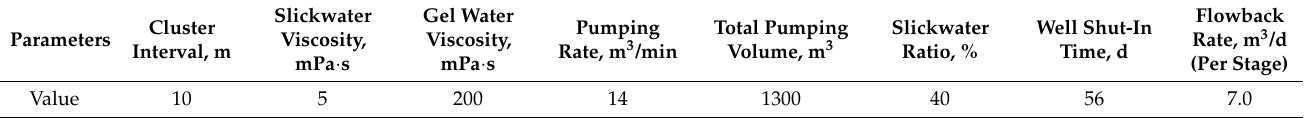
Table 3. Input well completion and schedule